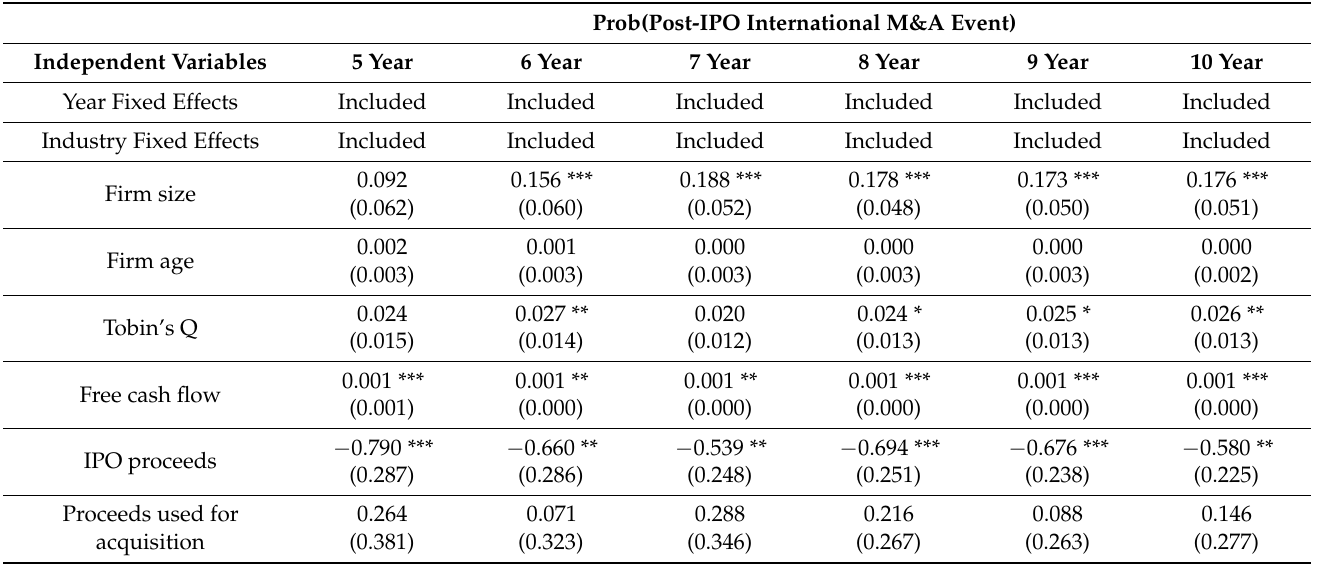
Table 4. Cox Regression Results for IPO Acquirers’ International M&A across